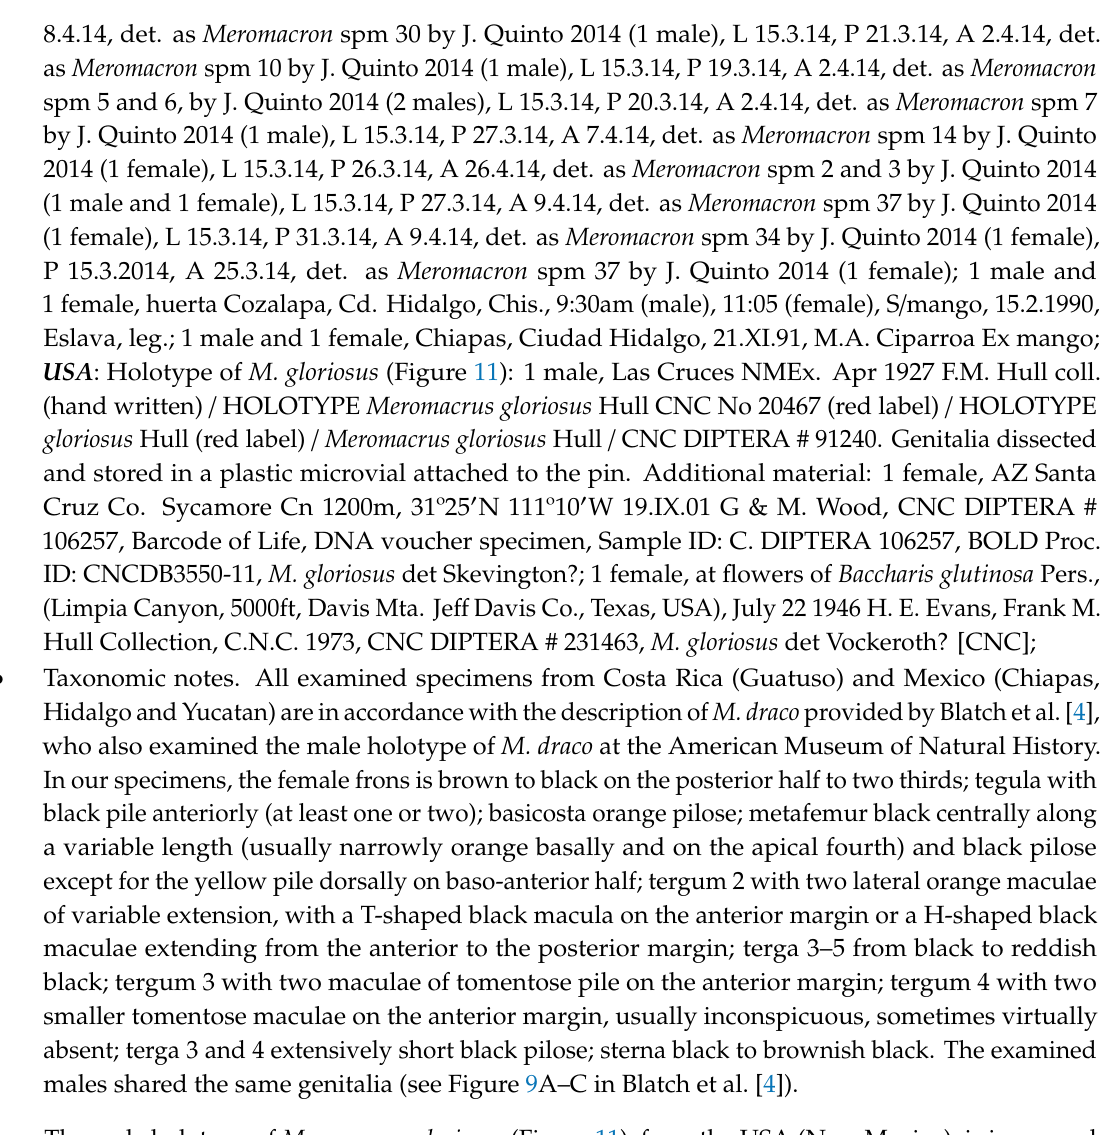
USA : Holotype of M. gloriosus (Figure 11): 1 male, Las Cruces NMEx. Apr 1927 F.M. Hull coll. (hand written) / HOLOTYPE Meromacrus gloriosus Hull CNC No 20467 (red label) / HOLOTYPE gloriosus Hull (red label) / Meromacrus gloriosus Hull / CNC DIPTERA # 91240. Genitalia